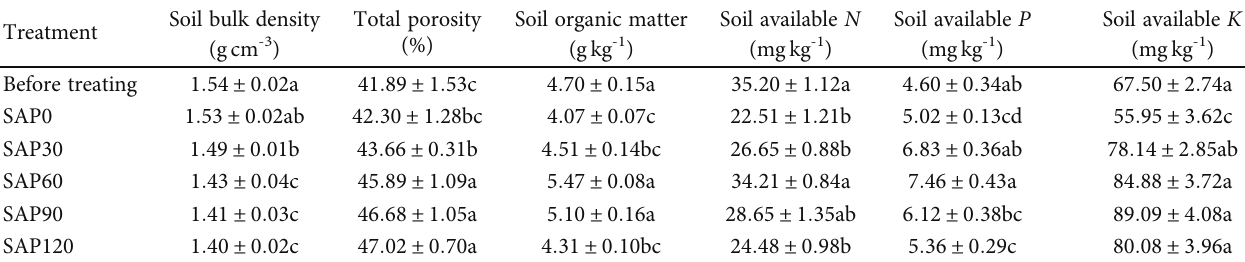
Table 3: E ff ects of multifunctional SAP doses on soil physicochemical characteristics in 0 – 0.40m layer.